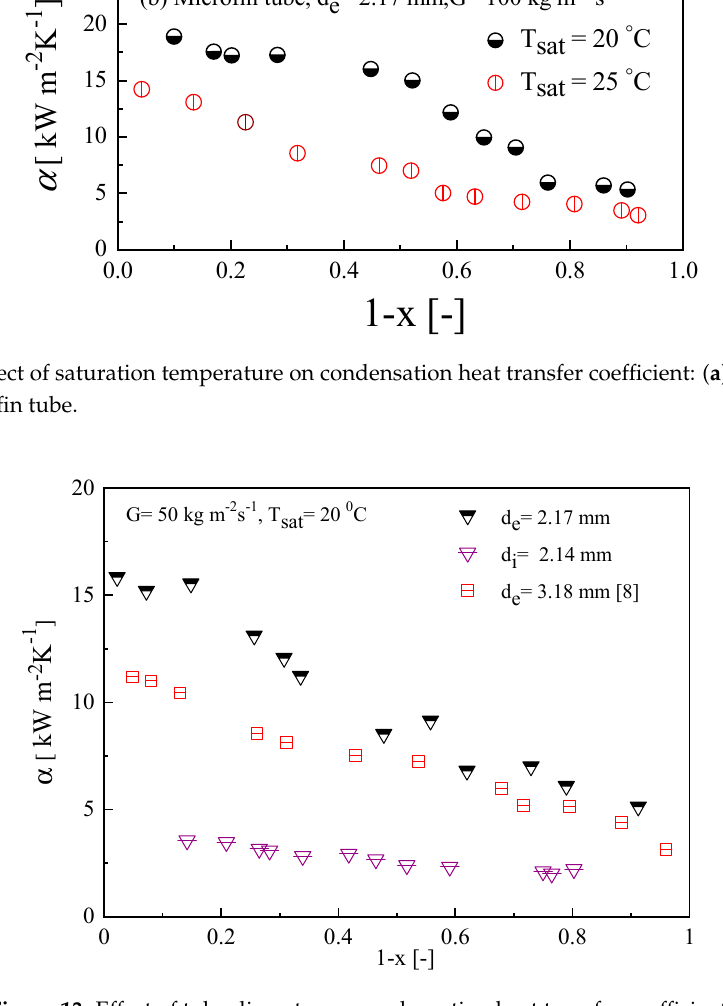
Figure 13. Effect of tube diameter on condensation heat transfer coefficient.